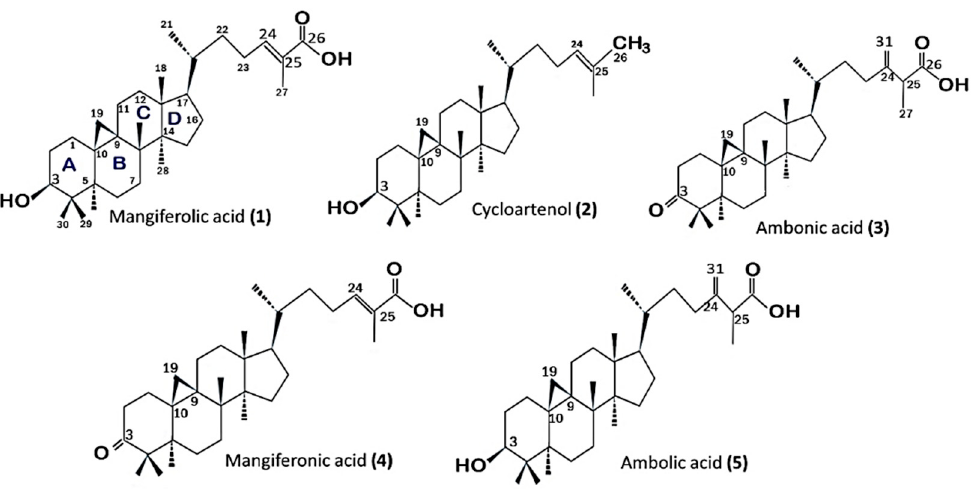
Figure 1. Structure of cycloartane-type triterpenes isolated from T. sapiens bee propolis in Southeast Sulawesi.